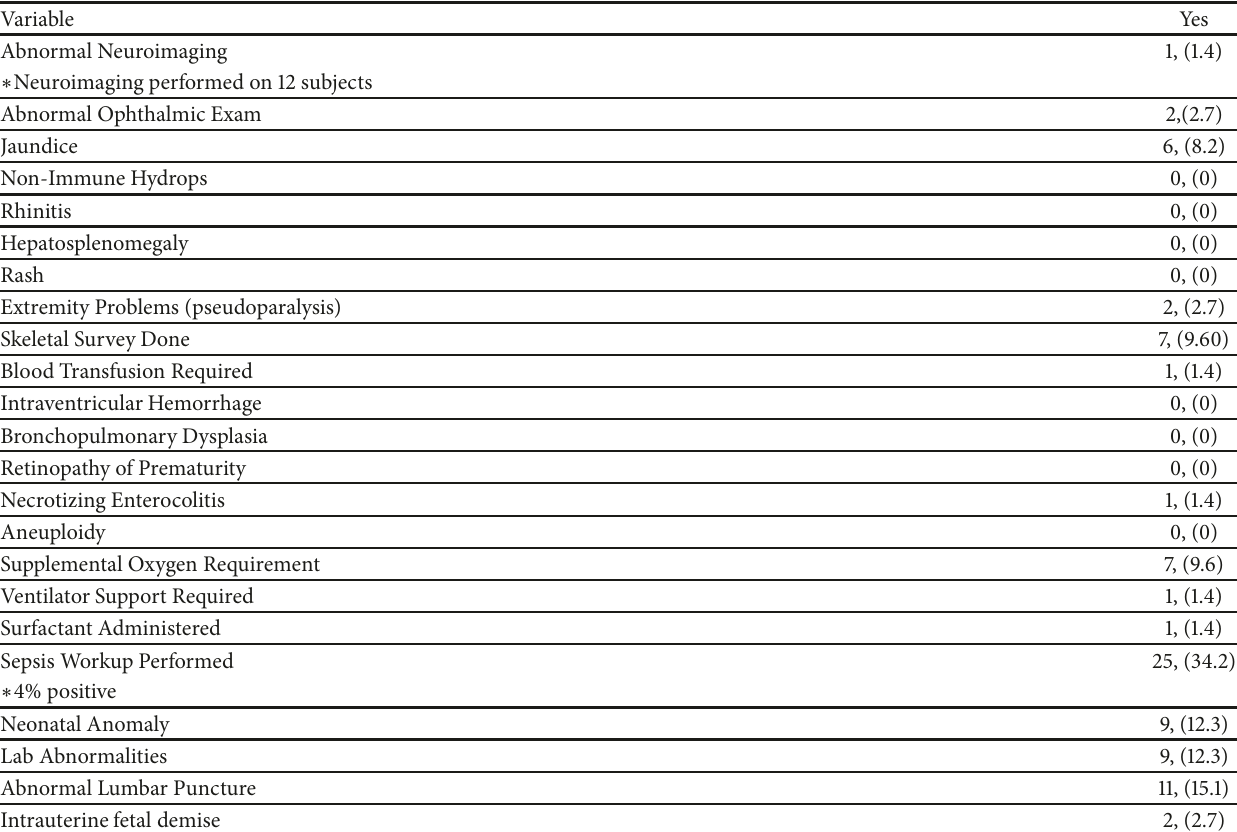
Table 5: Neonatal signs and symptoms: N =